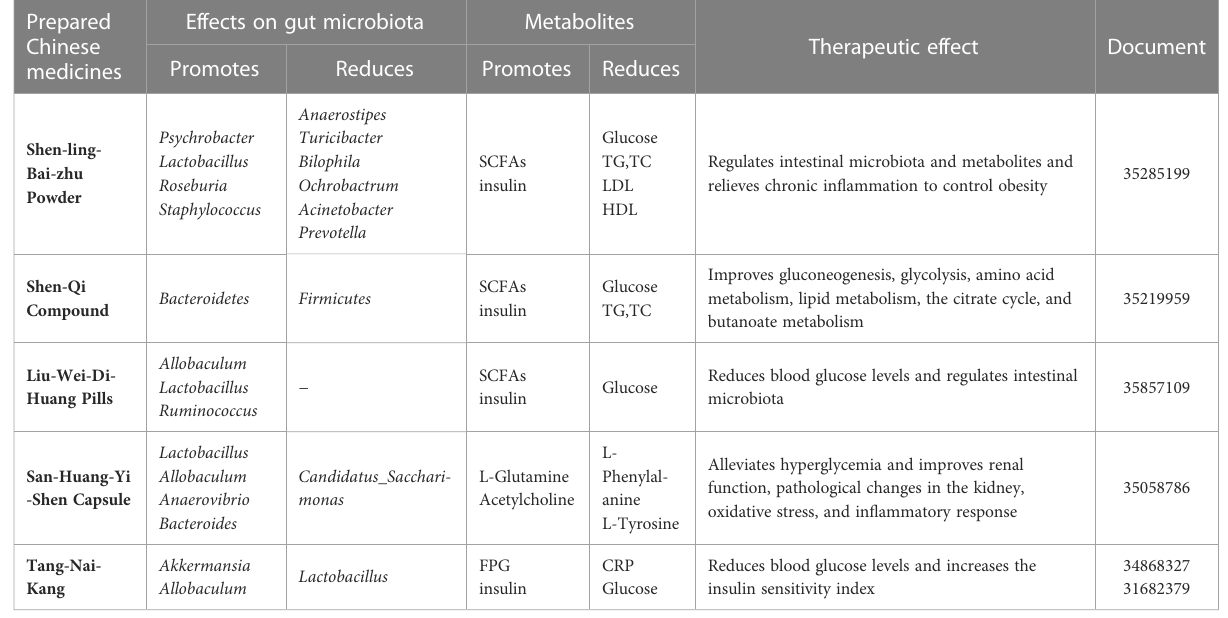
TABLE 3 Research progress of Chinese medicine preparations acting on intestinal microbiota in the treatment of diabetes